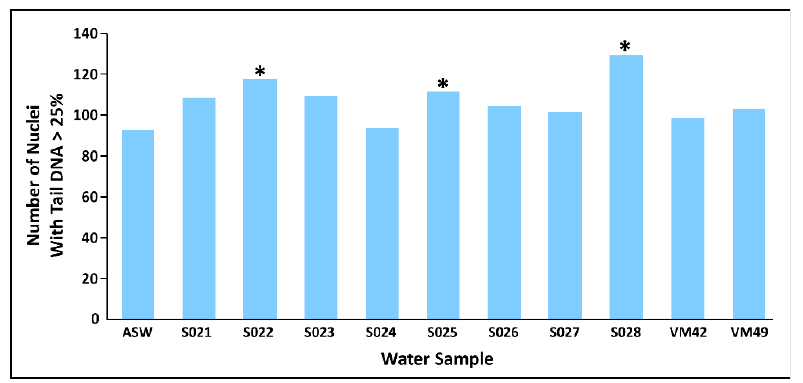
Figure 5. Genotoxicity tested on samples taken near the Sorek–Palmachim desalination plants’ outflows. A total of 300 nuclei were analyzed per site/treatment. Significant differences: *—significant result relative to modified-ASW control ( p < 0.017; following B-Y correction for multiple testing).